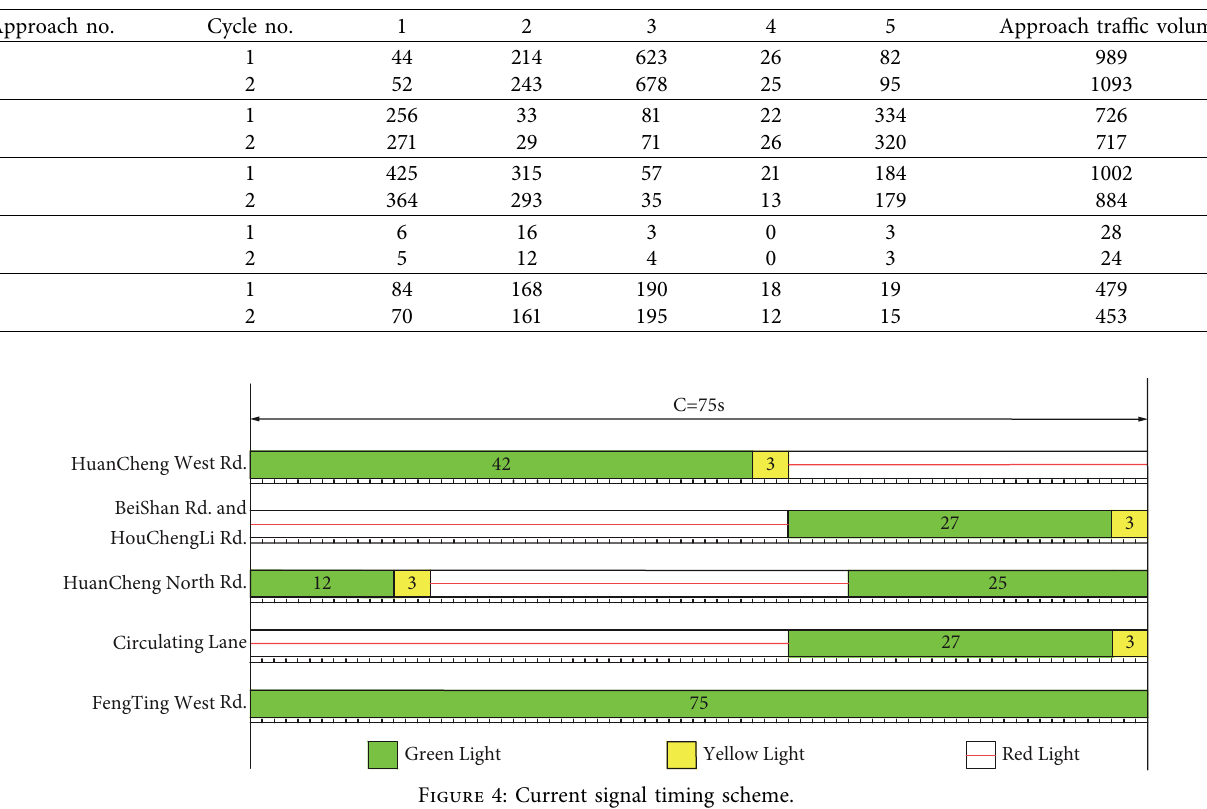
Figure 3: Current trafc organization of the roundabout. Table 2: Trafc volume (pcu/h).